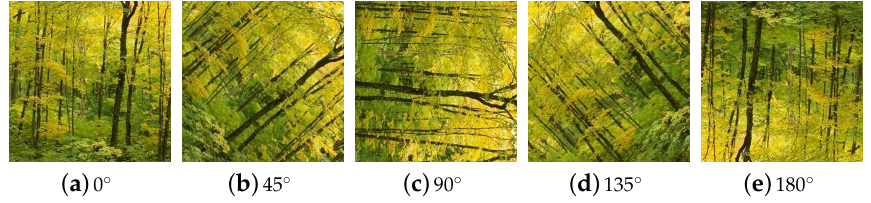
Figure 15. Rotation degrees applied to the images set.